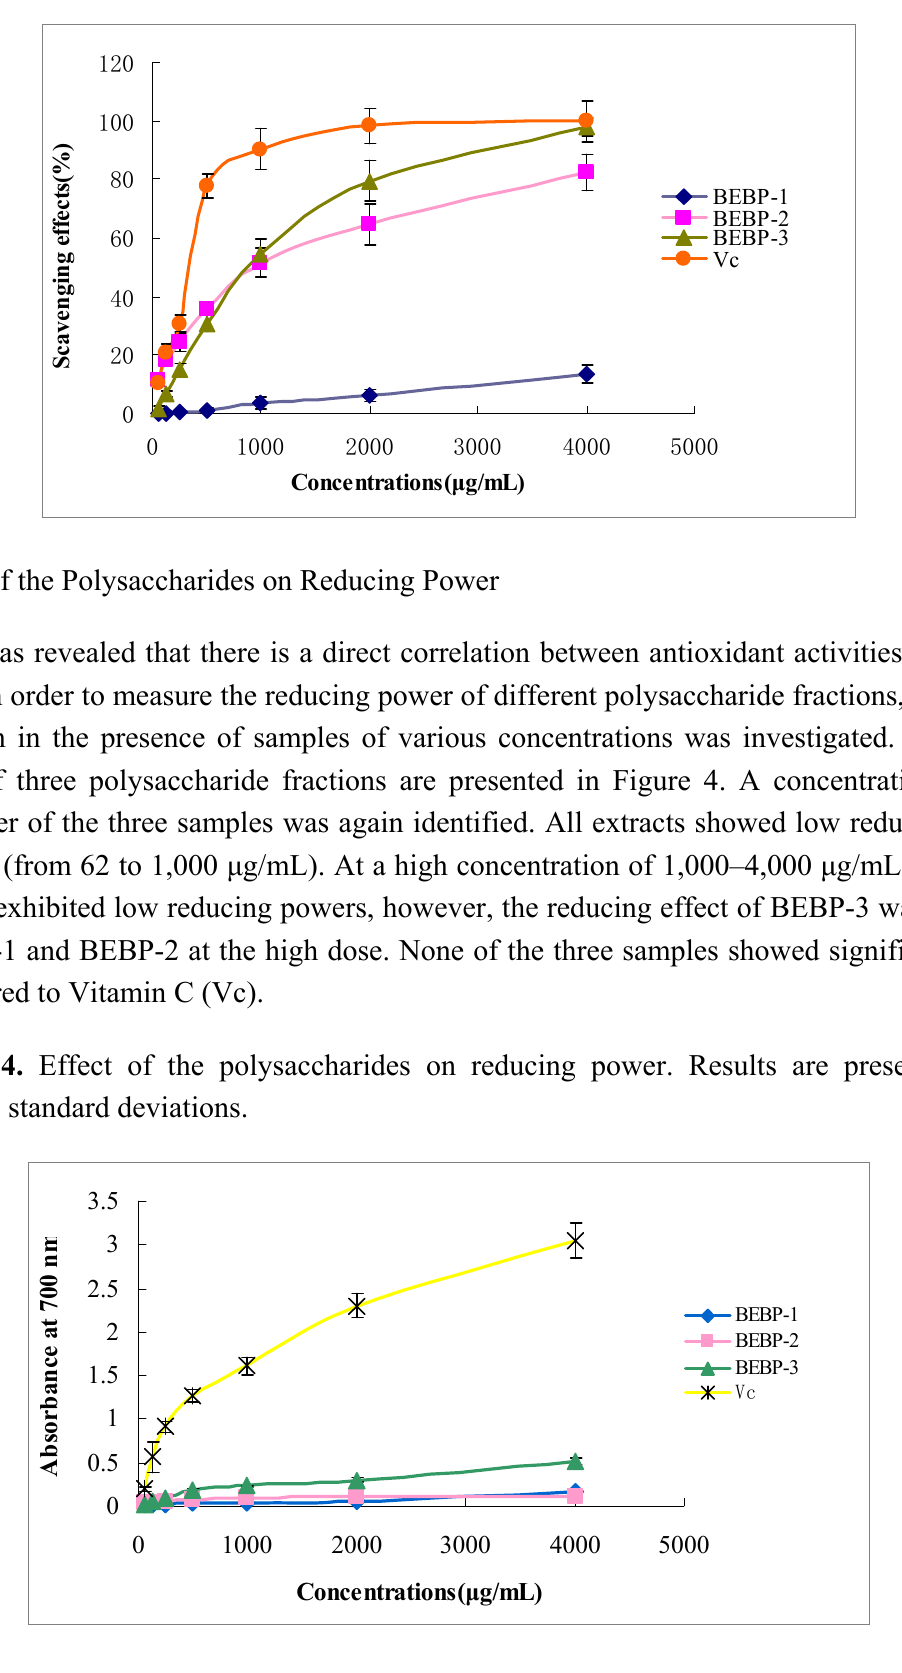
Figure 3. The scavenging effects of polysaccharides on ABTS radical. Results are presented as means ± standard deviations.